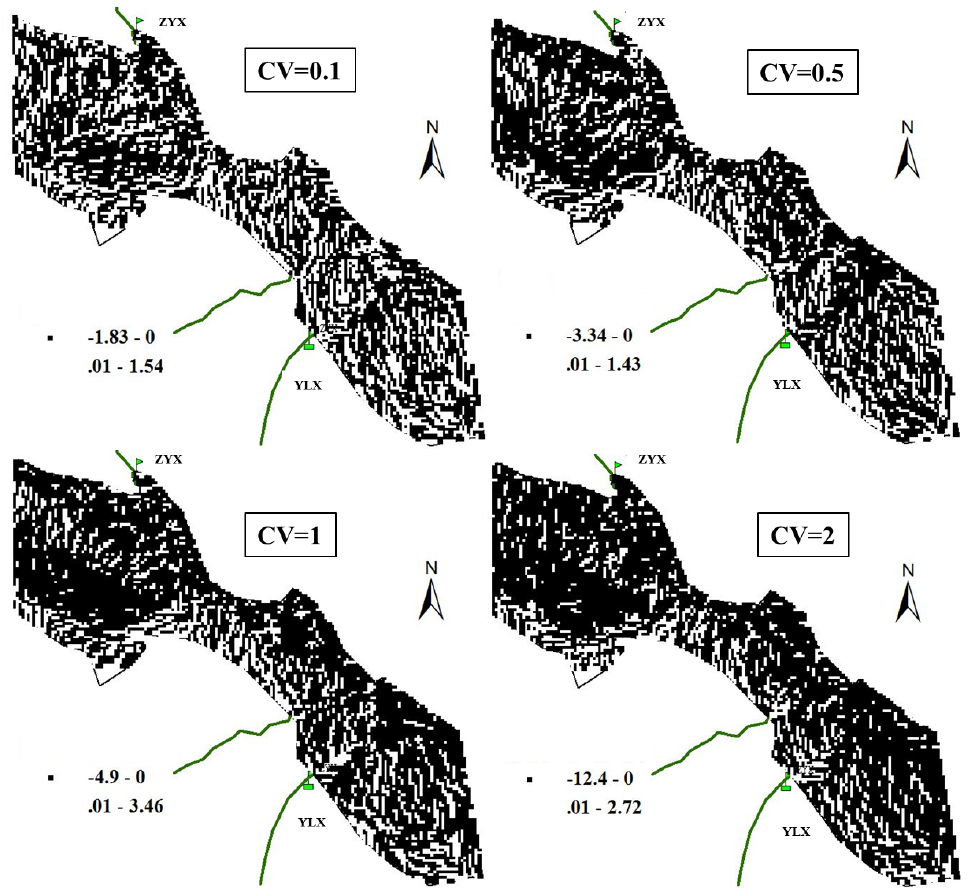
Figure 10. The field of normalized groundwater flow differences (cid:49)q(x) with grid-scale K(x)